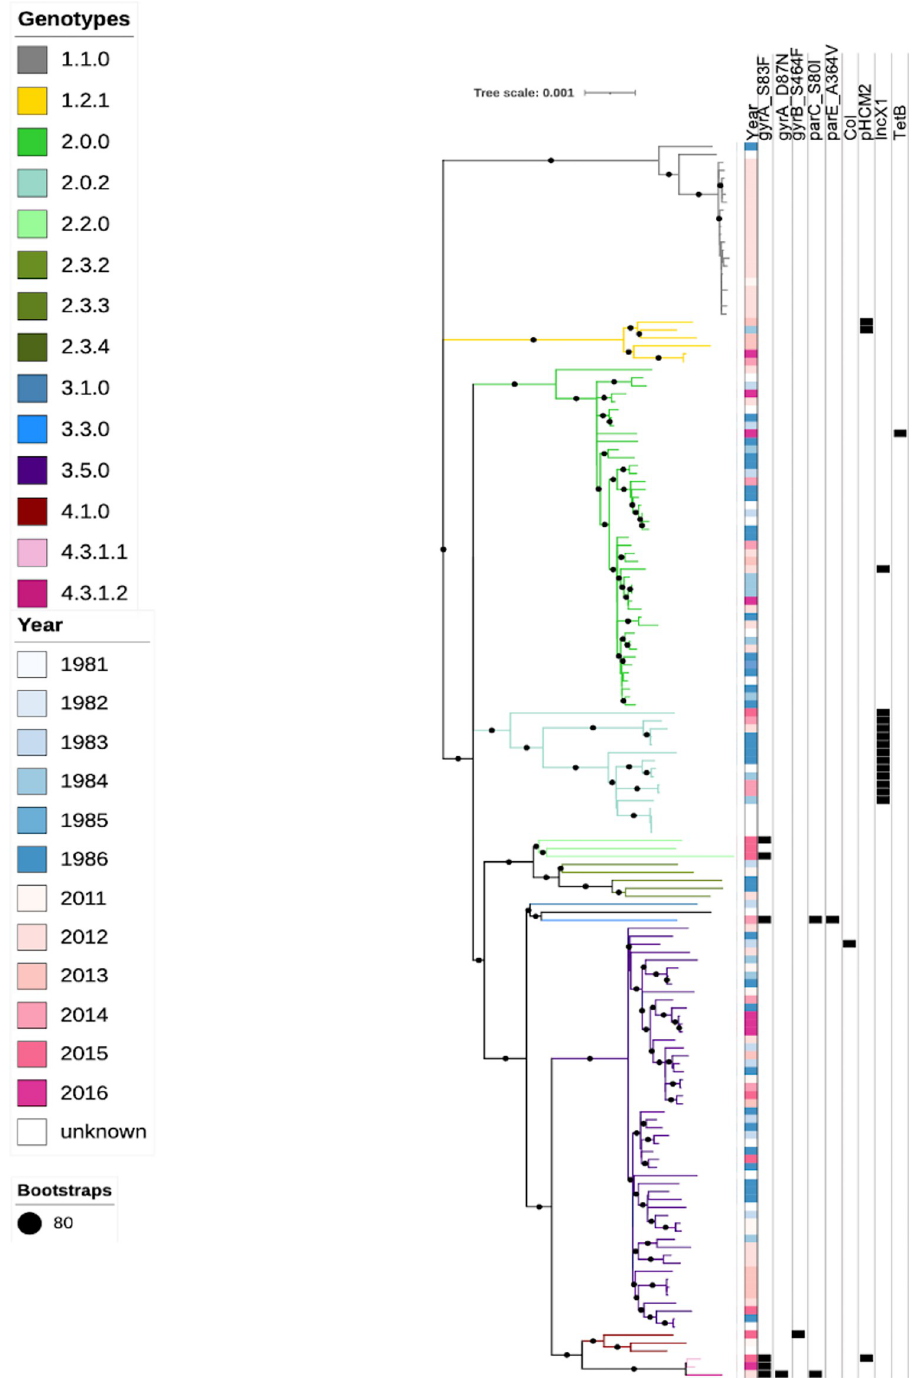
Fig 1. Genotypes and molecular determinates of AMR and plasmids in the Santiago collection. SNP based maximum likelihood core genome phylogeny indicating the genotypes of all the Santiago S . Typhi isolates is shown by the branch colour as per the inset legend. A diverse range of 14 genotypes were detected including 1.1, 1.2.1, 2, 2.0.2, 2.2, 2.3.2, 2.3.3, 2.3.4, 3.1, 3.3, 3.5, 4.1, 4.3.1.1, 4.3.1.2. Most of the isolates belonged to genotype 1.1, 2 and 3.5. Year of isolation, SNPs in the QRDR region associated with reduced susceptibility to fluoroquinolones as well as plasmids and detected resistance genes are shown in the columns adjacent to the tree. Bootstrap confidence of 80 or above is indicated with a black circle on the